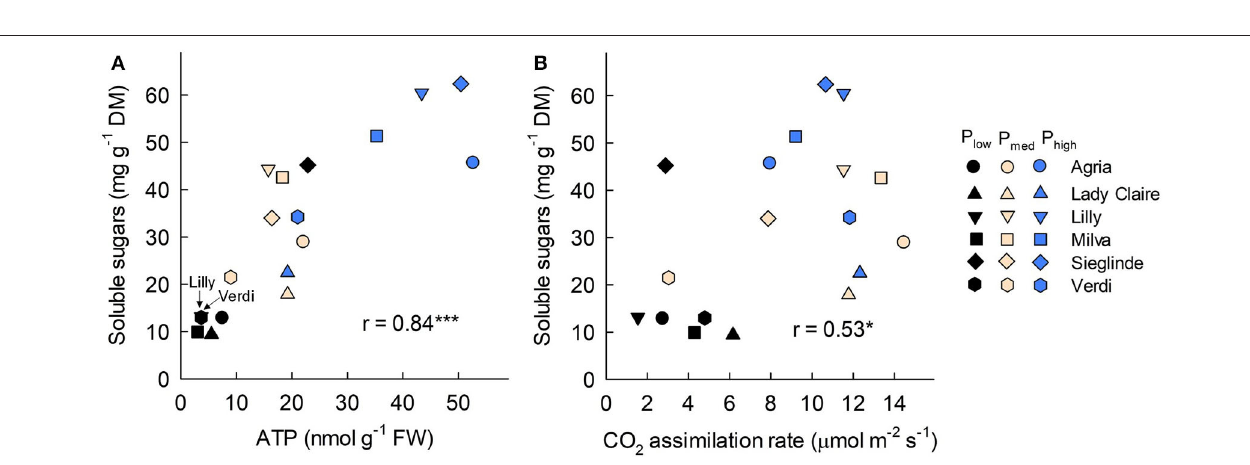
FIGURE 6 | Correlation among leaf soluble sugars with (A) adenosine triphospate (ATP) concentration and (B) CO 2 assimilation rate measured 53 DAE. FW, fresh weight; DM, dry matter; * and *** indicate significant correlation at p < 0.05 and p < 0.001,